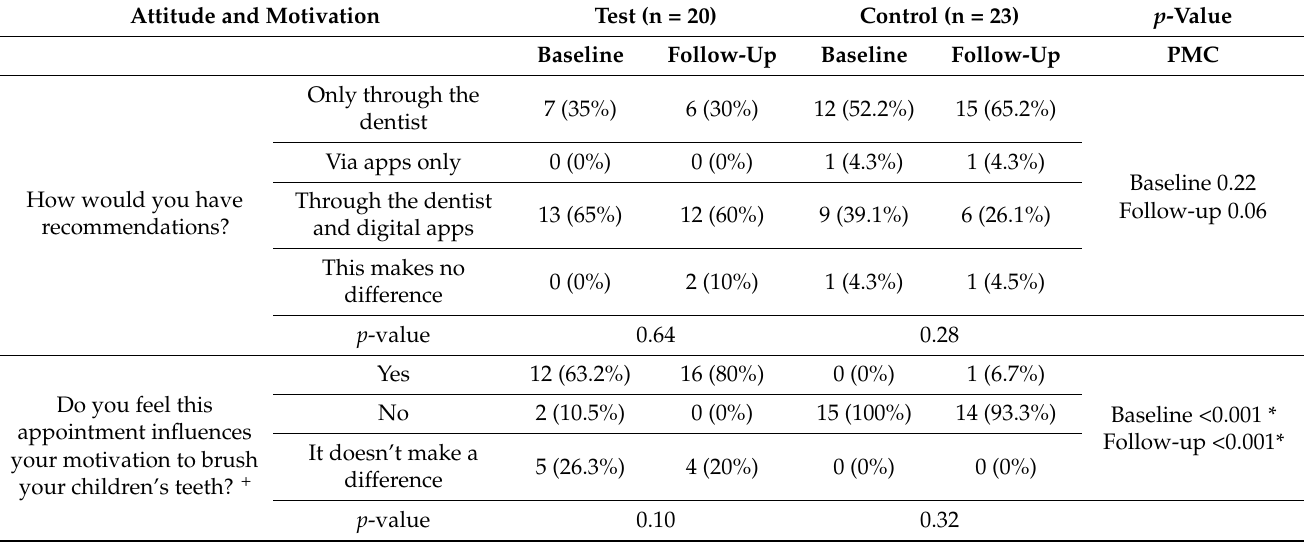
Table 6. Attitude and motivation at baseline and follow-up in the two study